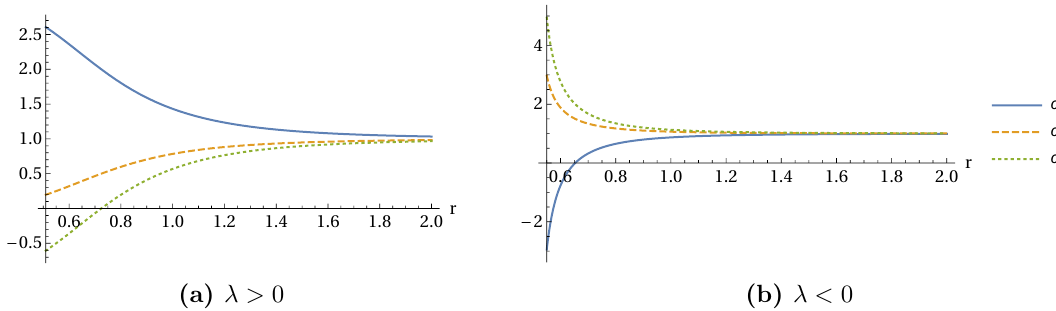
Figure 2. Speed of propagation for tensor, vector and scalar modes. For (cid:21) > 0, we have c T > c V > c S and c T > c V > 0 for all r . For (cid:21) < 0, we have c S > c V > c T and c S > c V > 0 for all r .